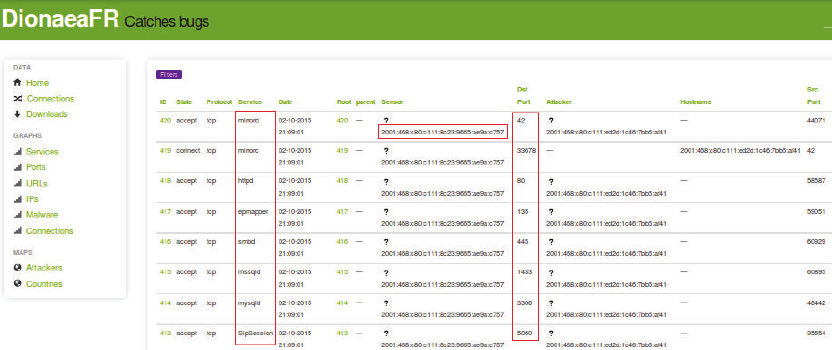
Figure 9: Nmap script to send test traffic on various services to a deployed honeypot.